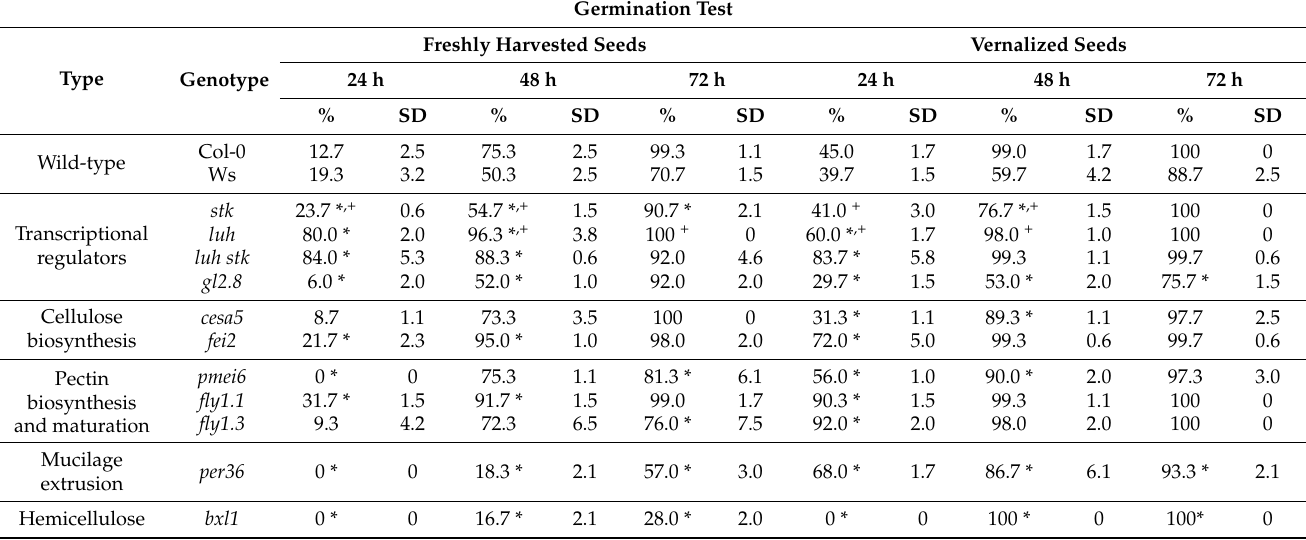
Table 1. Effects of the cell wall mutations in seed germination tested in freshly harvested and vernalized seeds over 24, 48, and 72 hours (h). Col-0 is the correspondent WT for all mutants and Wassilewskija (Ws) as the correspondent WT of bxl1 . Standard Deviations (SD) are representative of 3 biological replicates. Germination